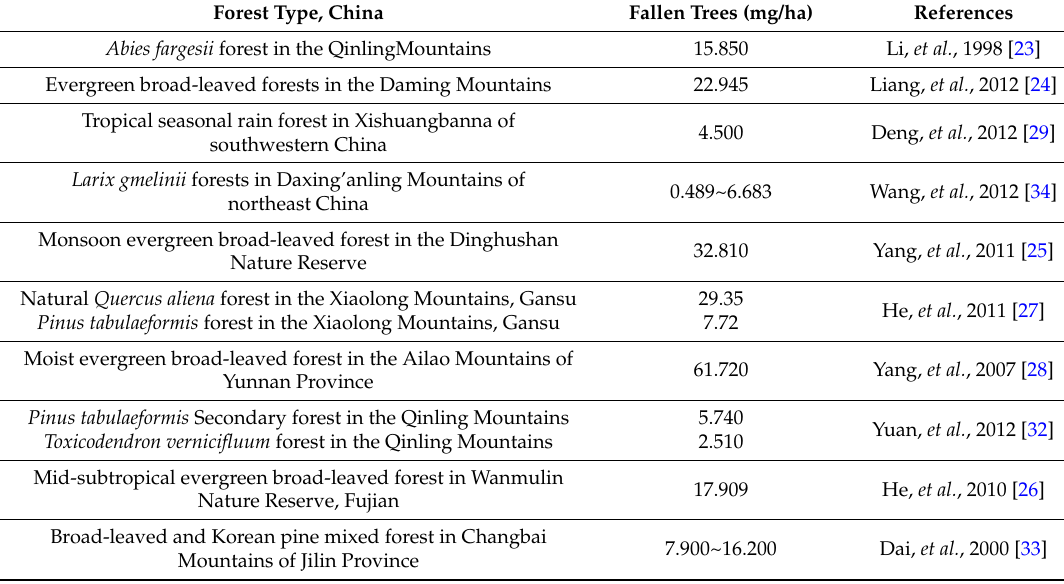
Table A2. Comparison of fallen tree biomass in various forest